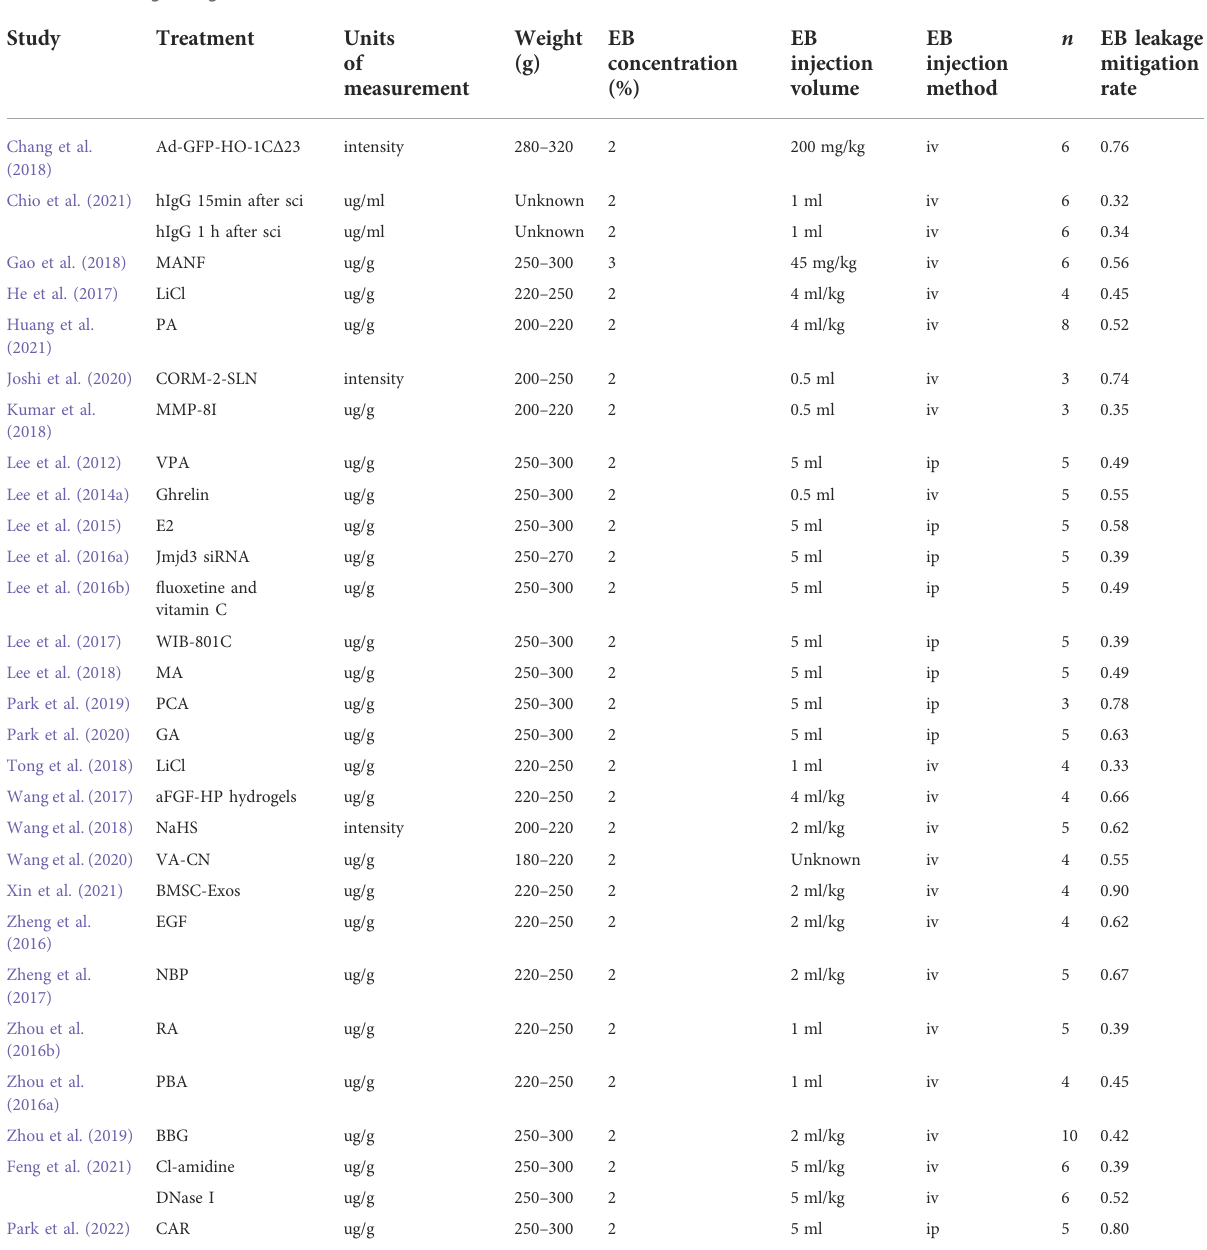
TABLE 4 EB leakage